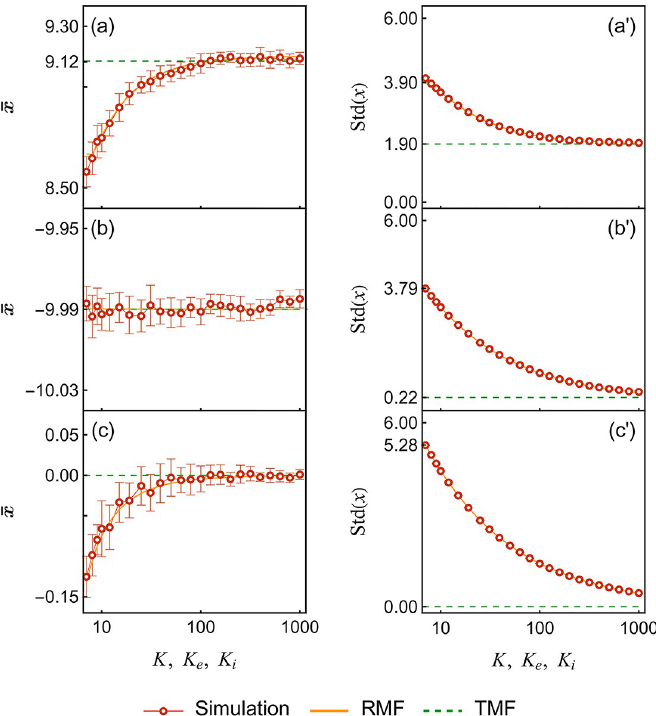
Fig 8. Finite-size effect. This figure shows the means and standard deviations of the internal variable of a neuron subjected to different configurations of input, varying the number of input channels. For all panels, E = 20 and I = − 20, μ e = E / K e , μ i = I / K i . Panel (a) and (a’): excitation only, β e = 50 Hz. Panel (b) and (b’): inhibition only, β i = 50 Hz. Panel (c) and (c’): K e = K i = K , β e = β i = 50 Hz. For the simulated data, we use the same methods described in the captions of Figs 6 and 7 to compute the values (points) and standard deviations (error bars). Parameters: a = ln(100)/20 � 0.23, h = 1 Hz, τ = 10